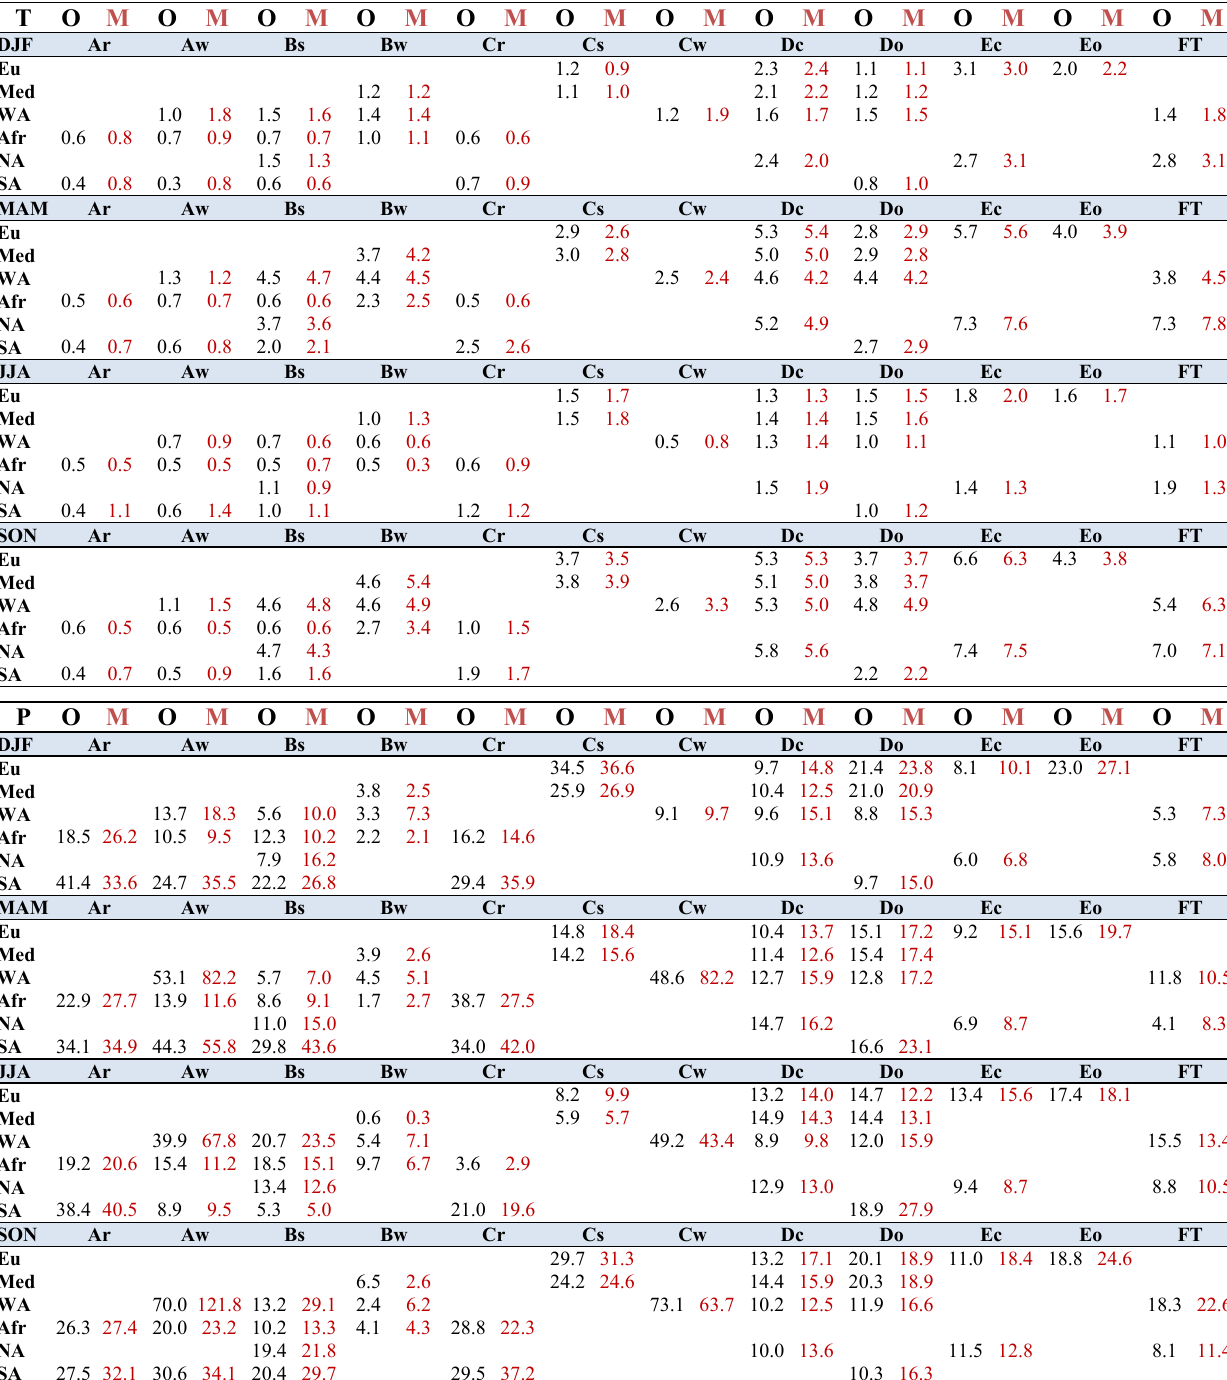
Table 2. Standard deviation for monthly values of temperature (T: upper part) and precipitation (P: lower part) between CRU observations (O: black) and REMO (M: red) during different seasons for all climate types and regions inside the period